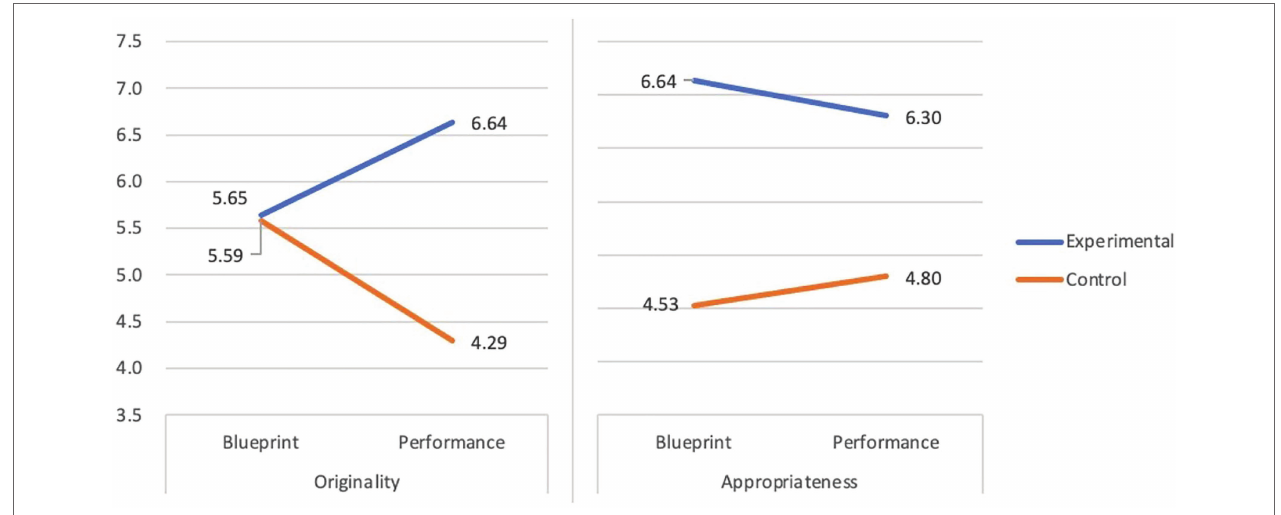
FIGURE 2 | The improvement of team-level creativity in the experimental group and the control